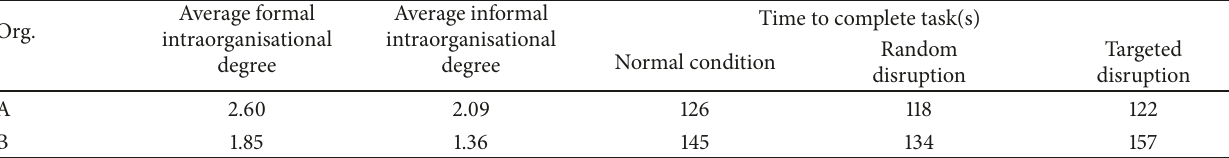
Table 12: Relation between average intraorganisational level degrees and task performance in normal and disrupted conditions.